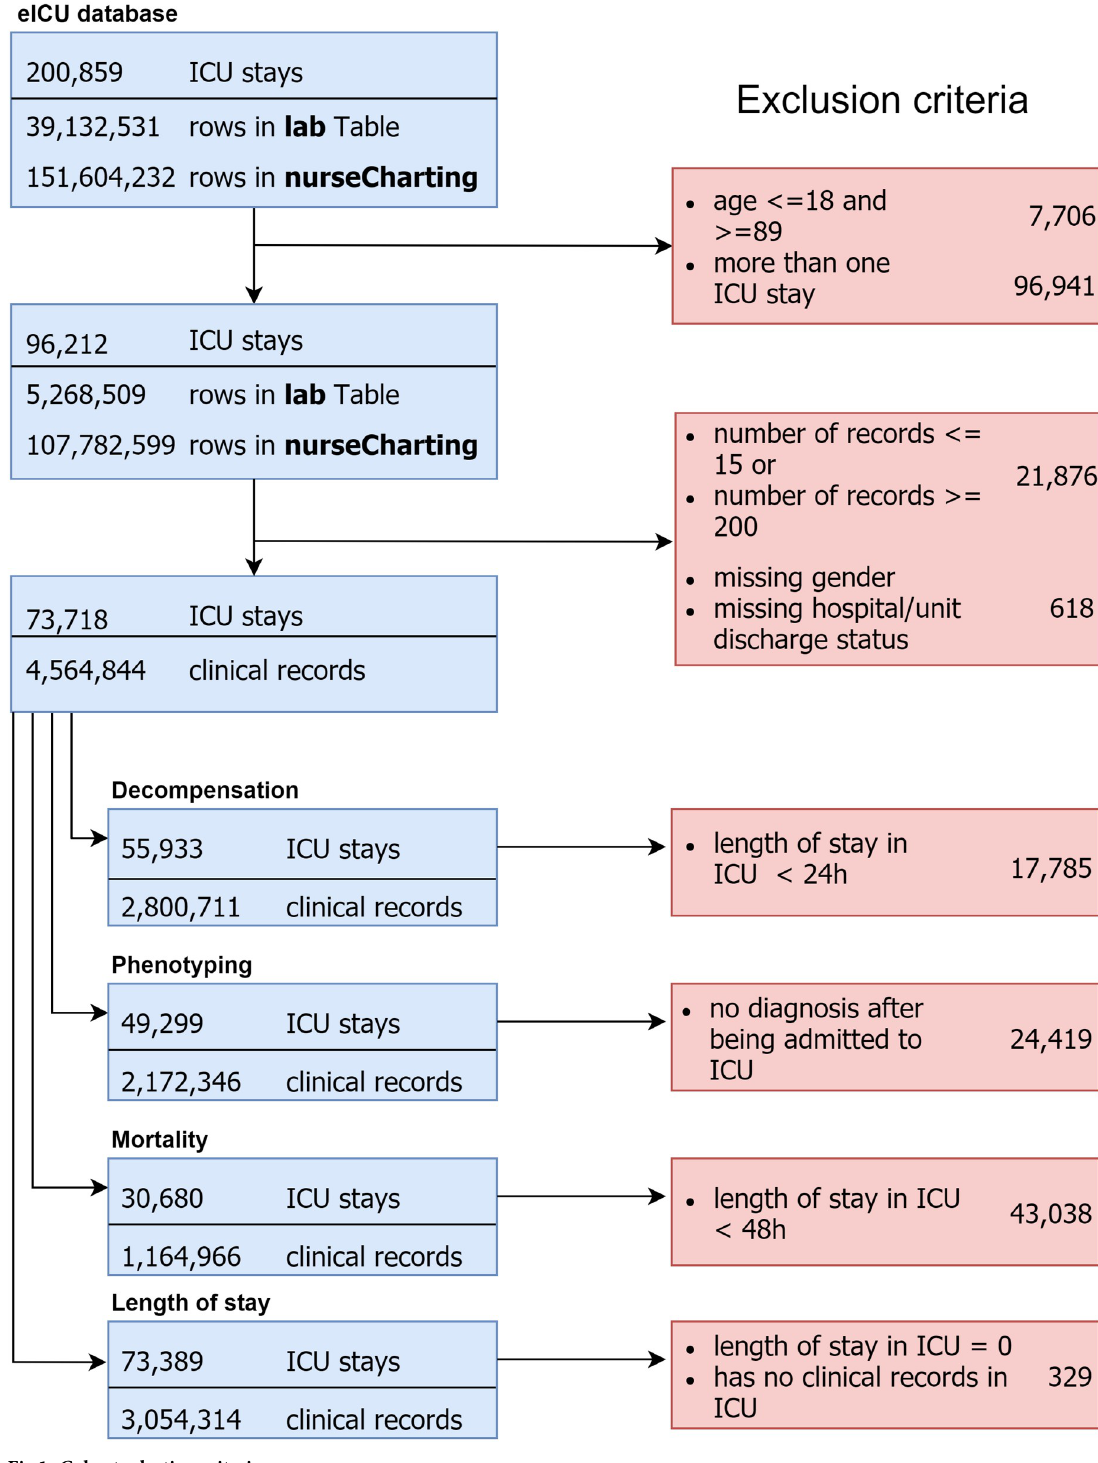
Fig 1. Cohort selection criteria.